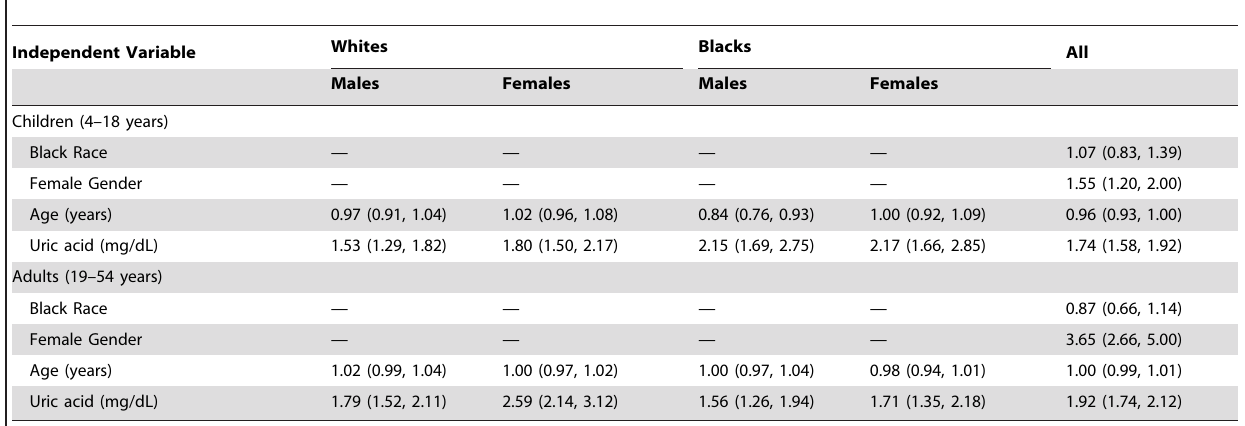
Table 3. Odds ratios (95% confident interval) of uric acid for MetS in children and adults by race and gender.